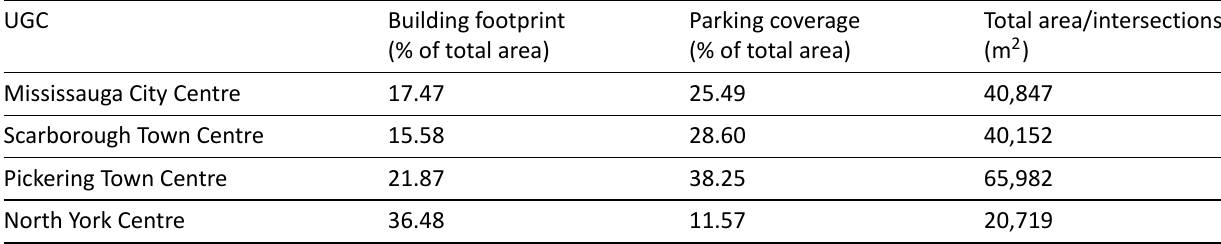
Table 2. Building footprint, parking coverage and area/intersection quotient of the four Toronto suburban